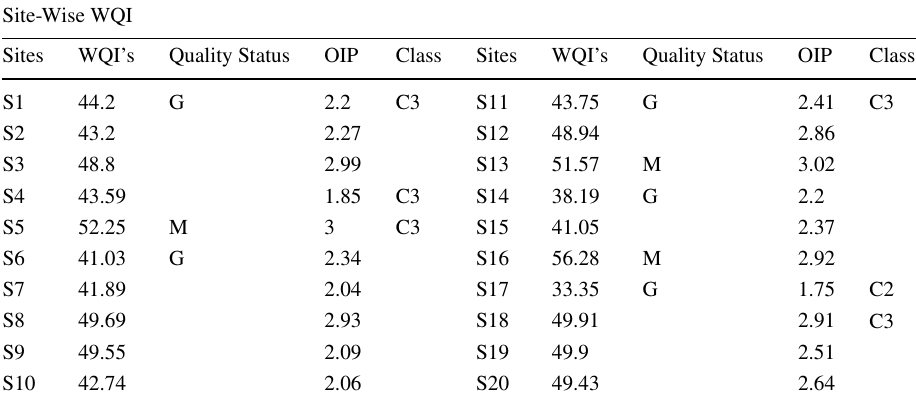
Table 5 Site-wise water quality